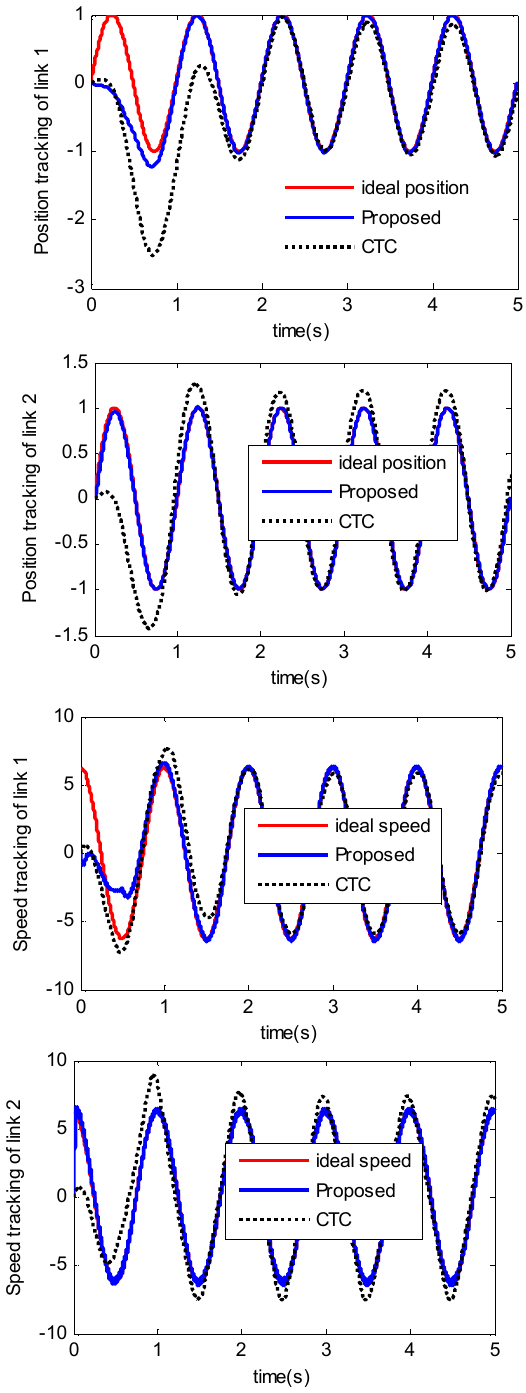
Fig. 1. Results for system uncertainty.